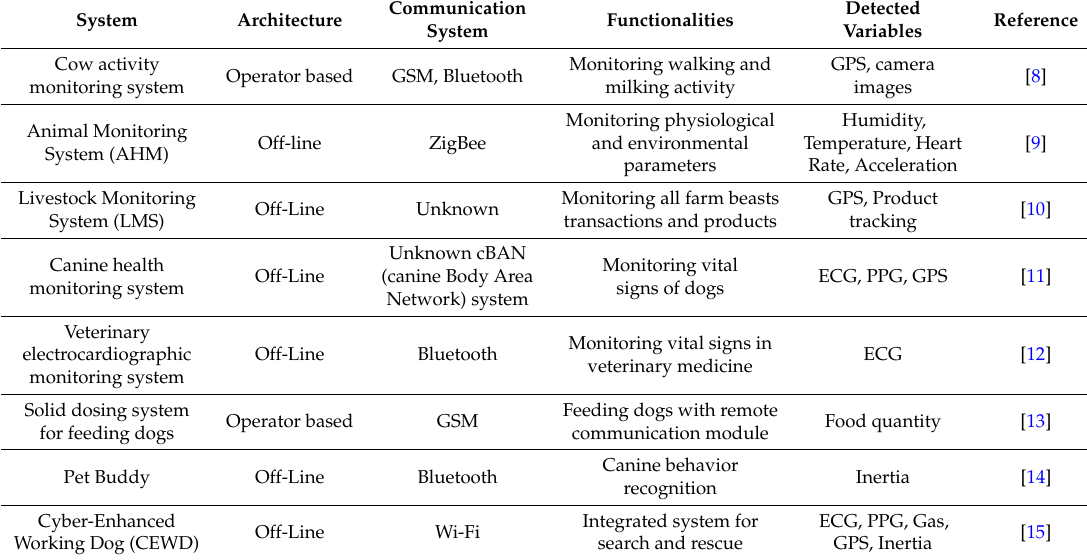
Table 1. Animal monitoring system